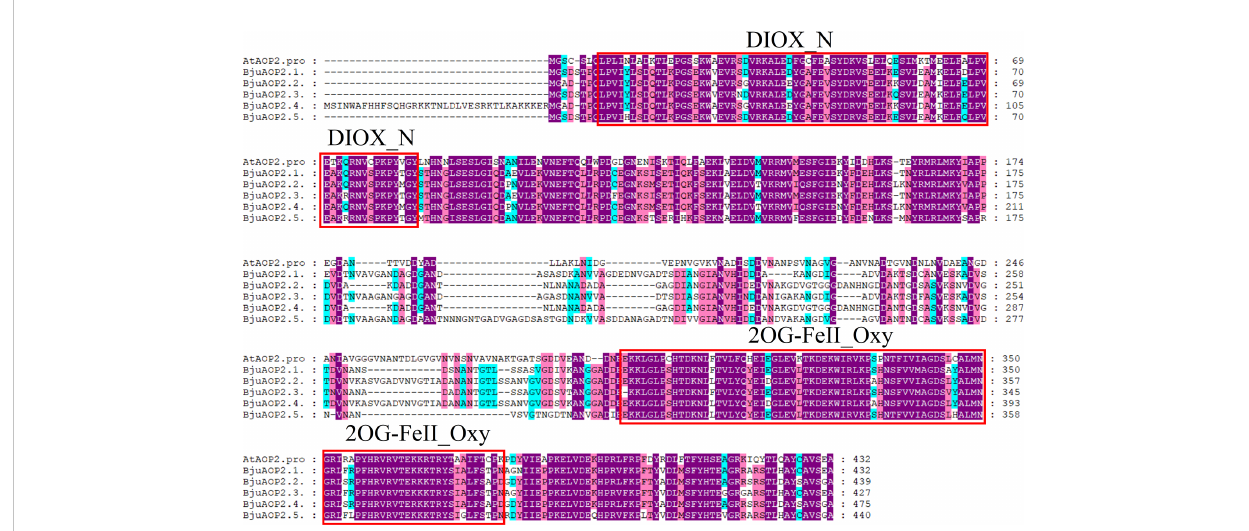
FIGURE 1 Multiple-sequence alignment of Tumorous stem mustard BjuAOP2 and AtAOP2 protein sequence. Multiple alignments were performed using the MEGA11 software. The red solid boxes represent the structural domains of 2OG-FeII_Oxy and DIOX-N. The purple, blue and pink shading indicates 100%, 80% and 60% conserved percent, respectively.